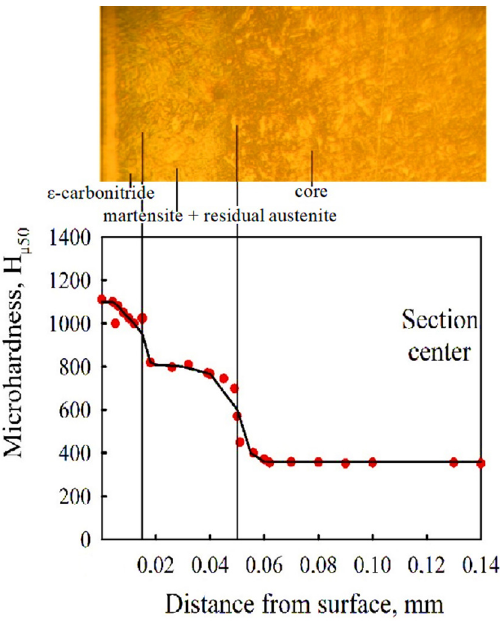
Figure 10. Structure and hardness of steel 60Si2Cr after nitrocarburizing under temperature 550 °C and duration 3 h.